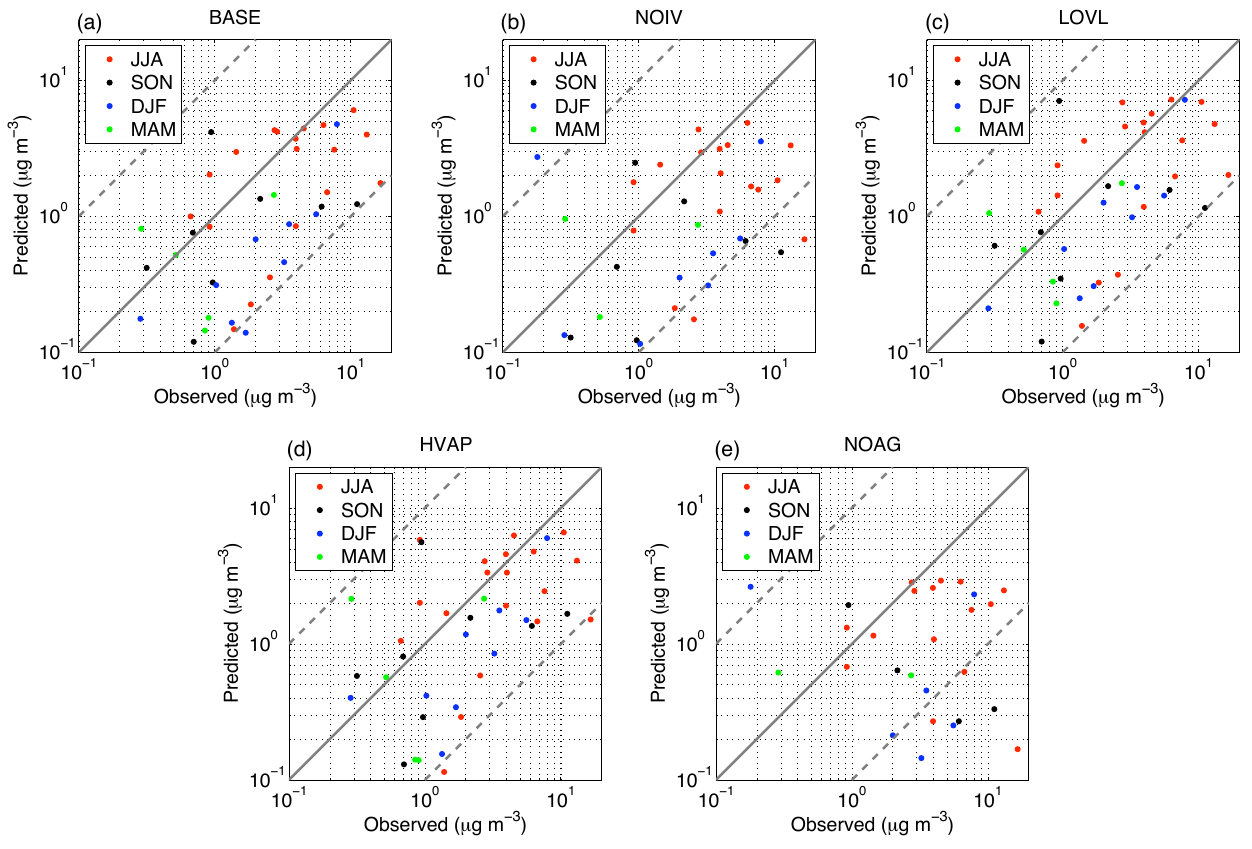
Fig. 8. Scatter plot comparing model predictions from BASE, LOVL, NOIV, HVAP and NOAG with observed values at rural, remote and marine sites across the globe (Liousse et al., 1996; Chung and Seinfeld, 2002; Zhang et al., 2007). Red represents the months of June, July and August (JJA), black represents the months of September, October and November (SON), blue represents the months of December, January and February (DJF) and green represents the months of March, April and May (MAM) The solid grey line is the 1:1 line and the dashed lines are the 1:10 and 10:1